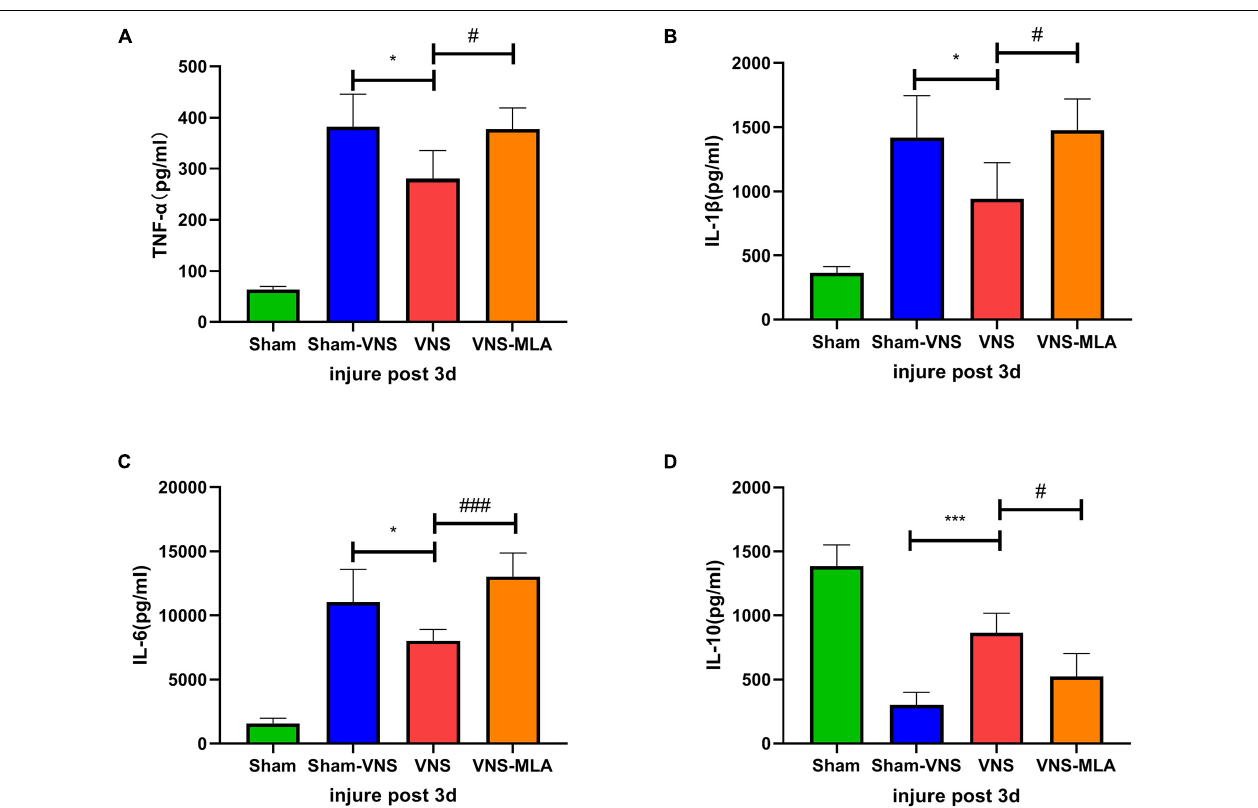
FIGURE 4 | Vagus nerve stimulation (VNS) promotes changes in neuroinflammation after spinal cord injury (SCI). (A–C) Changes in the levels of the pro-inflammatory cytokines TNF- α , IL-1 β , and IL-6, n = 5 per group. (D) Changes in the levels of the anti-inflammatory cytokines IL-10, n = 5 per group. * P < 0.05, *** P < 0.001 VNS vs. Sham-VNS group. # P < 0.05, ### P < 0.001 VNS vs. VNS-MLA